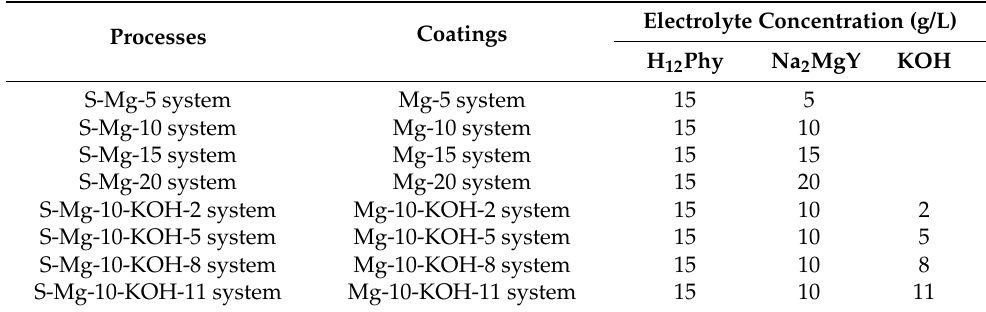
Table 1. The fabricated MAO coatings and the corresponding electrolytes compositions.